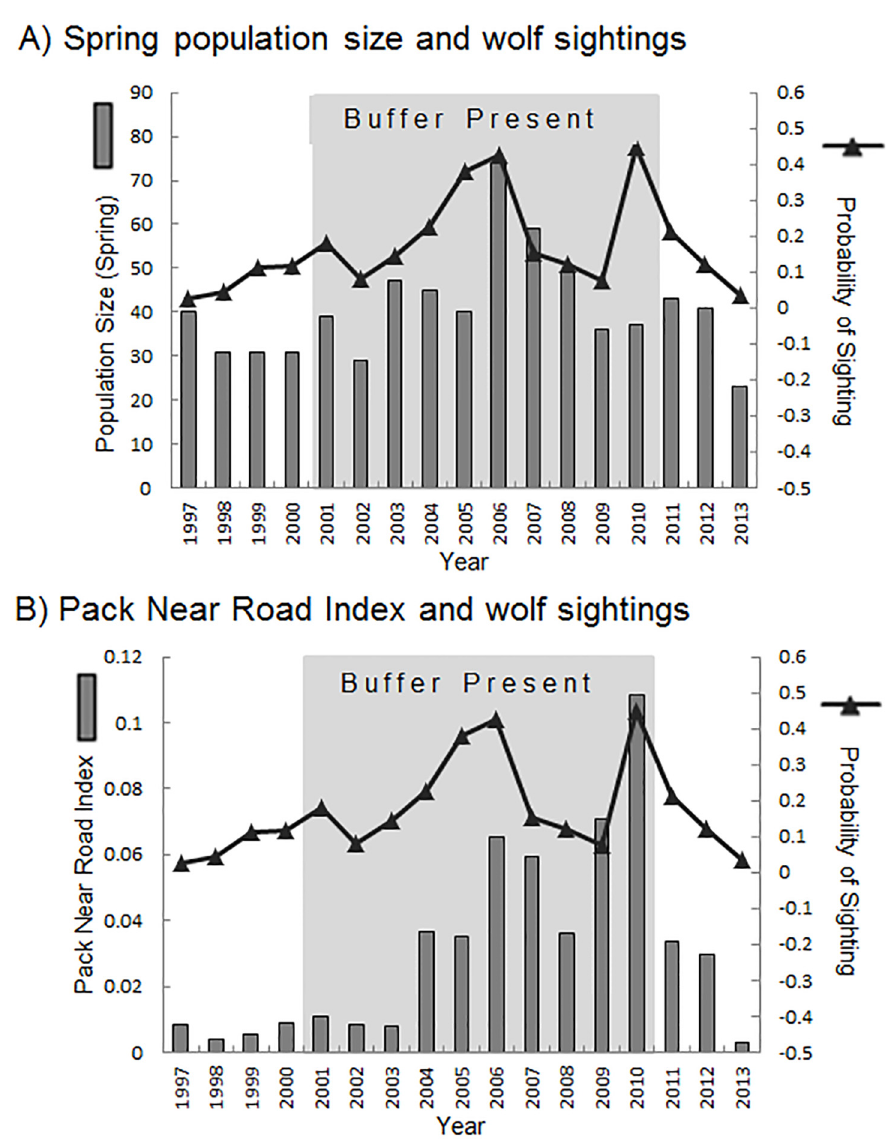
Fig 2. Probability of wolf sighting along the Denali Park Road from 1997 to 2012 (black triangles) in relation to A) spring population size (gray bars) and B) the Pack Near Road Index (number of wolves in road packs divided by den distances from the road, gray bars) in Denali National Park and Preserve, Alaska, USA. Shaded areas indicate the time period (2000 – 2010) when a harvest buffer zone adjacent to the park was in